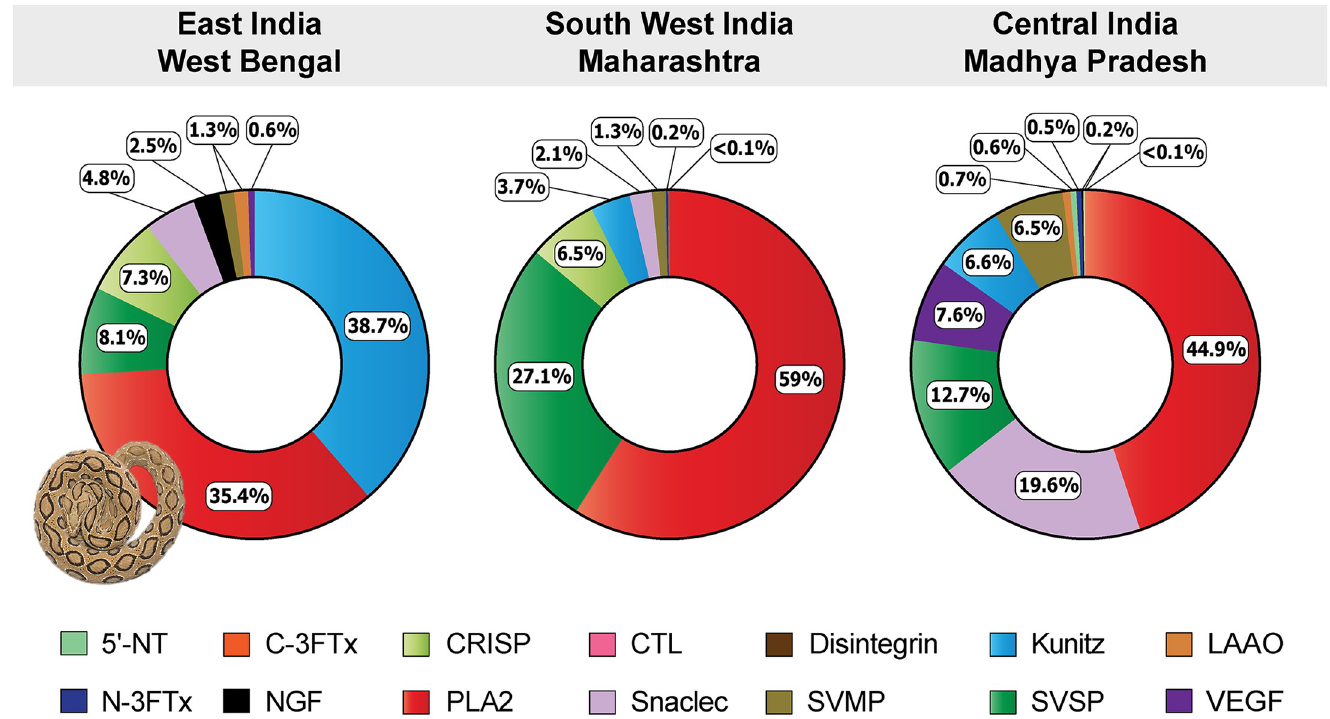
Fig 3. Comparative venom profiles of the biogeographically disparate D . russelii populations. This figure represents the relative composition of various toxins constituting D . russelii venoms, as estimated from the mass spectrometry and HPLC data. Each toxin type is uniquely colour coded, and its relative abundance is